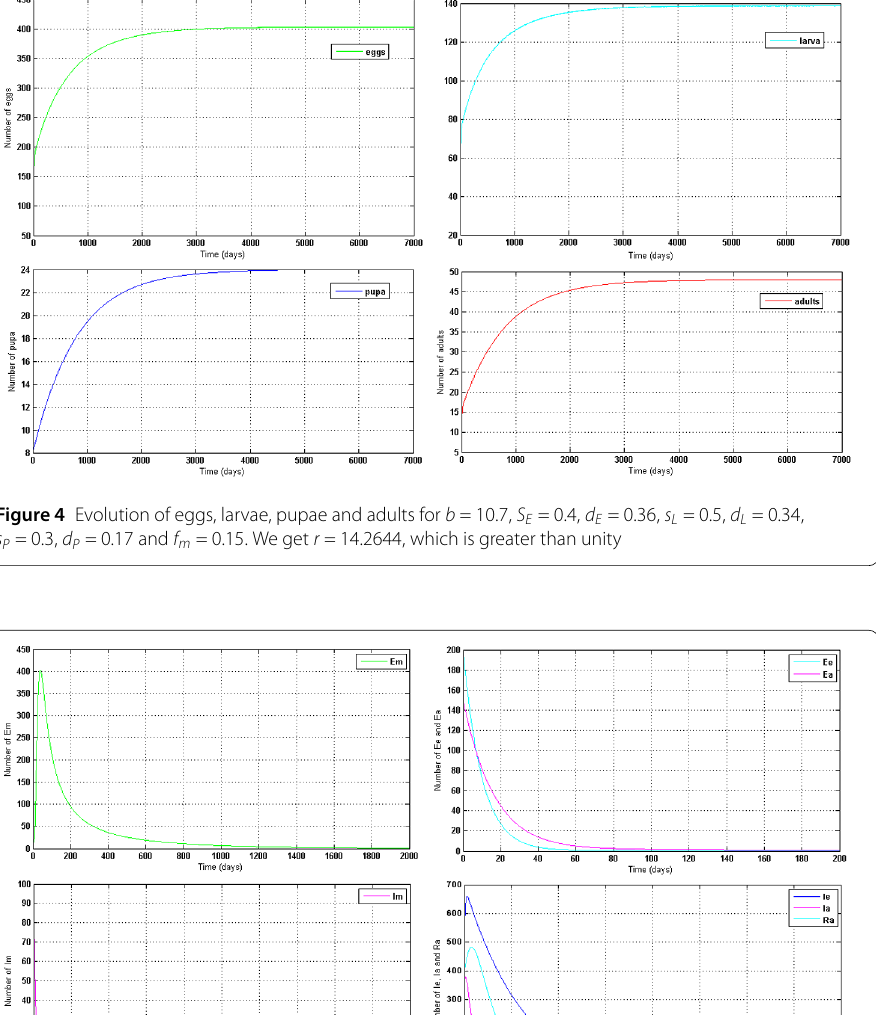
R a (0) = 400, S m (0) = 50, E m (0) = 15, I m (0) = 100 for humans and the above numerical